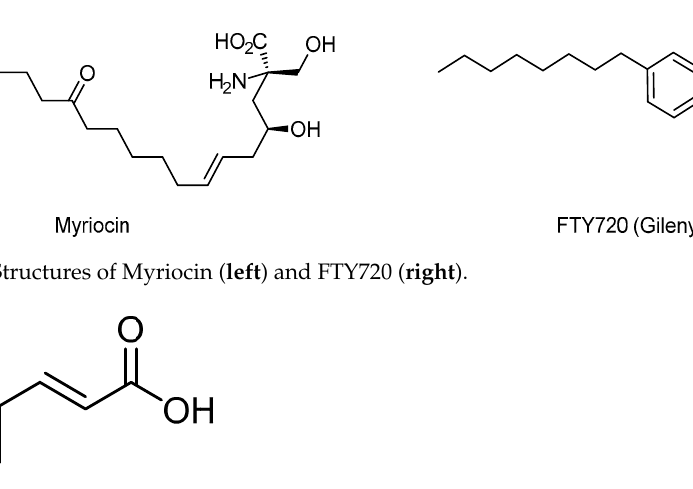
Figure 7. Structure of monomethyl fumarate.